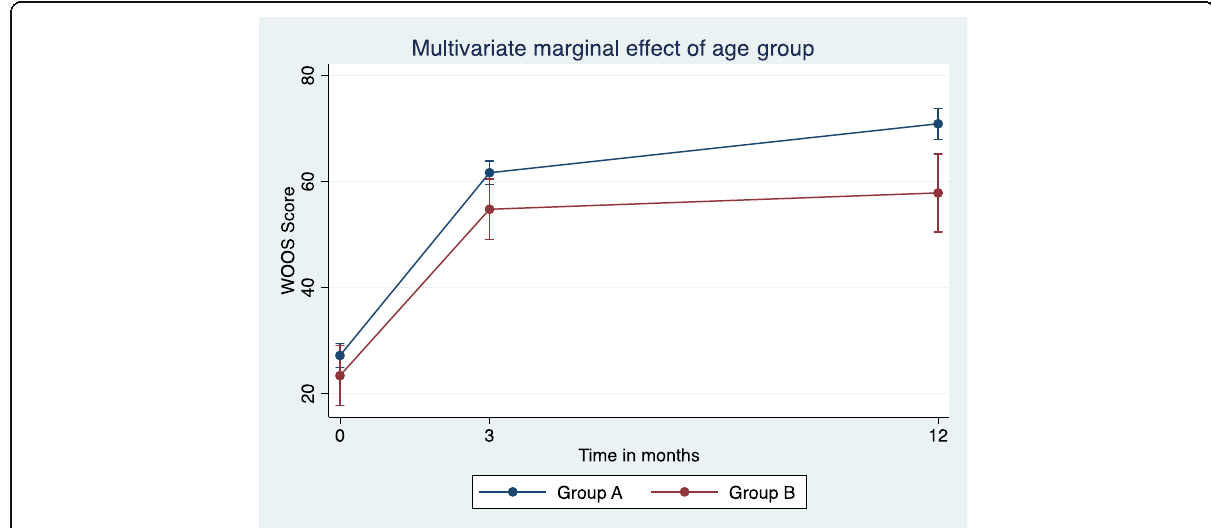
Fig. 2 Estimated multivariate marginal change over time in WOOS with 95% CI significantly changed in both groups, and the older